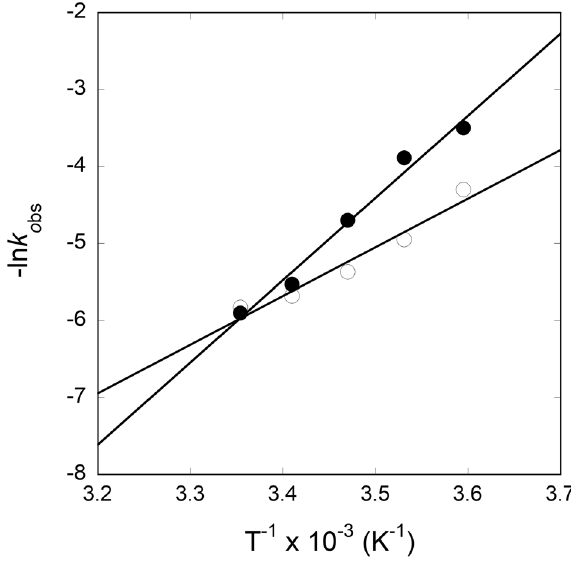
Figure 11. Arrhenius plots for determining the interaction between APP IREmRNA and IRP1 with and without iron. Temperature-dependent observed rate constant of IRP1·APP IRE mRNA (—Ο—) and IRP1·APP IRE mRNA-Fe 2+ (— ● —) complex was used for the plots. The final concentrations of APP mRNA, IRP1, and Fe 2+ were 500 nM, 100 nM, and 50 μM, respectively.